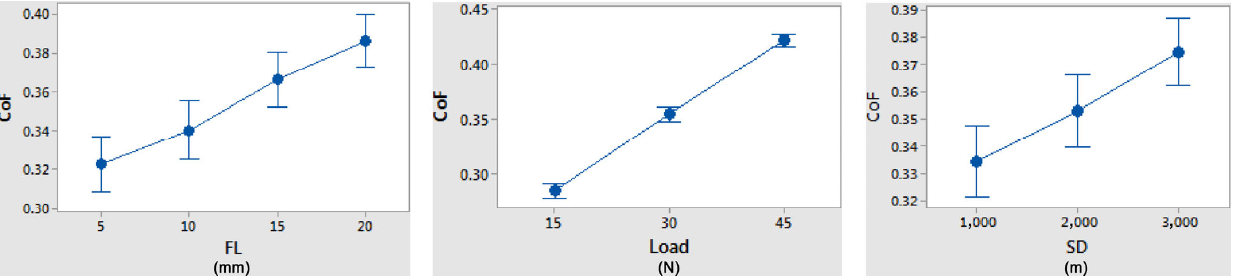
Fig. 7 Main effect plots for